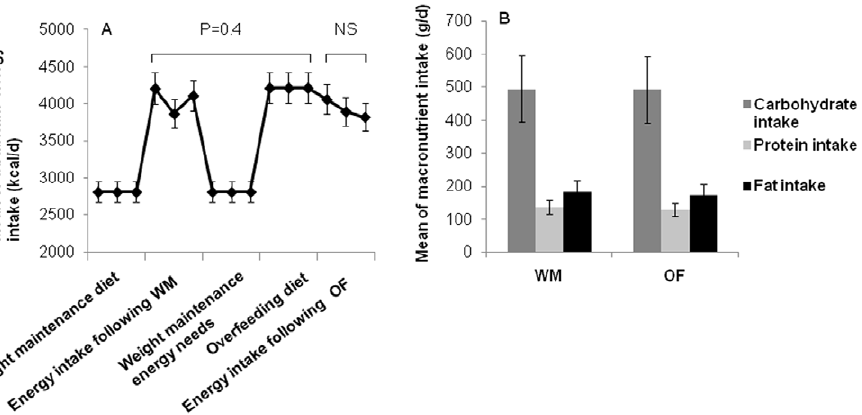
Figure 2. Mean daily energy and macronutrient intake following weight maintenance diet (WM) and overfeeding diet (OF). Fig. 2A. Daily energy intake during the study for each day. Ad libitum mean daily energy intake was 4061 6 1084 (kcal/d) following WM, and 3926 6 1284 (kcal/ d) following OF. There was no difference in mean of daily energy intake (p=0.4) between WM vs. OF. A decline in energy intake over 3 day ad libitum food intake period following OF is noted, but the trend was not significant (p=0.9). Fig. 2B. Mean of daily carbohydrate, protein, and fat intake were 484 6 126 (g/d), 138 6 42 (g/d), 183 6 61 (g/d) following WM, and 477 6 156 (g/d), 129 6 45 (g/d), and 173 6 74 (g/d) following OF. No difference was found in carbohydrate (p=0.7), protein (p=0.2) or fat (p=0.3) intake between WM vs. OF. All data are means 6 SD. Paired t-test was used to analyze differences between diets. doi:10.1371/journal.pone.0036225.g002 PLoS ONE |